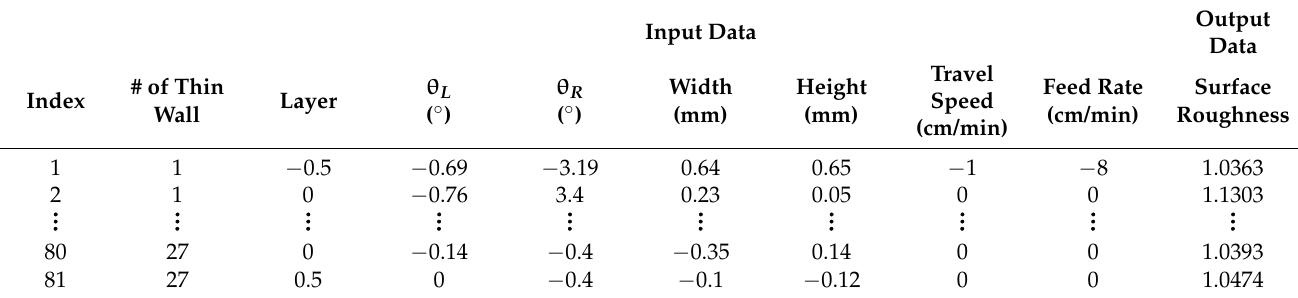
Table 4. Data normalization.